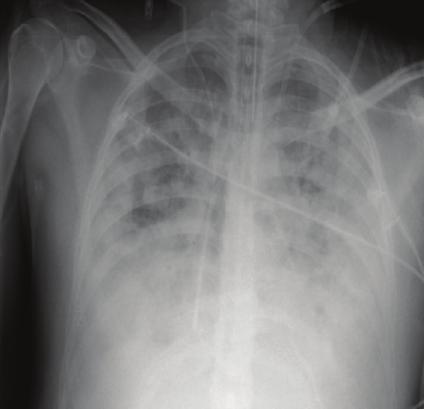
Figure 3: Last chest X-ray at the ICU, showing worsening diffuse bilateral nodular and patchy